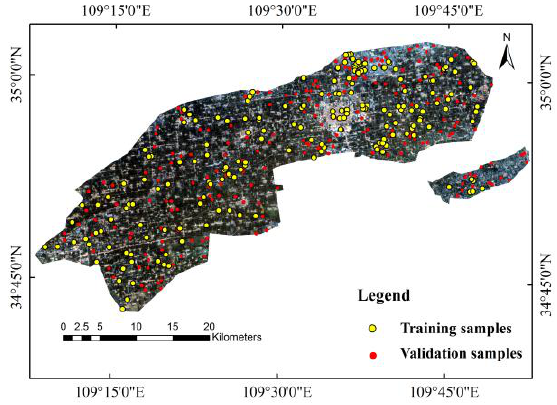
Figure 2. The distribution of ground-truth